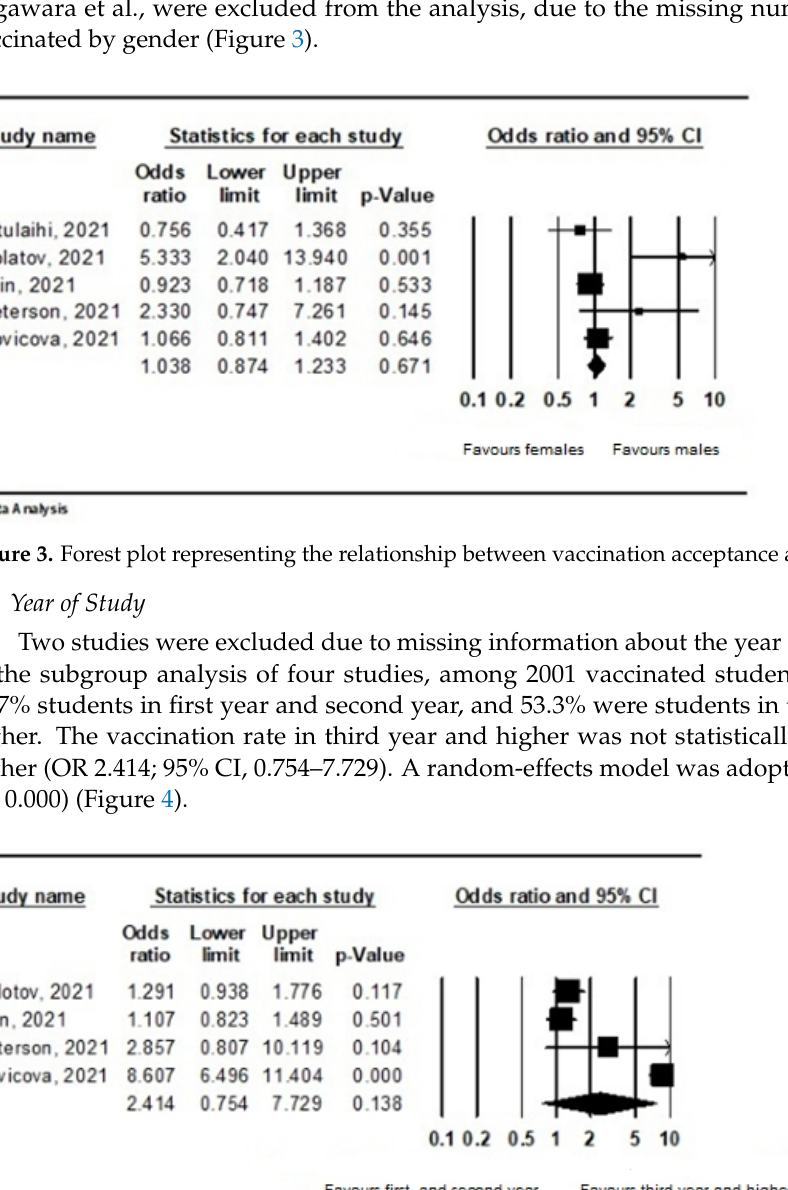
Figure 2. Forest plot of vaccination prevalence.